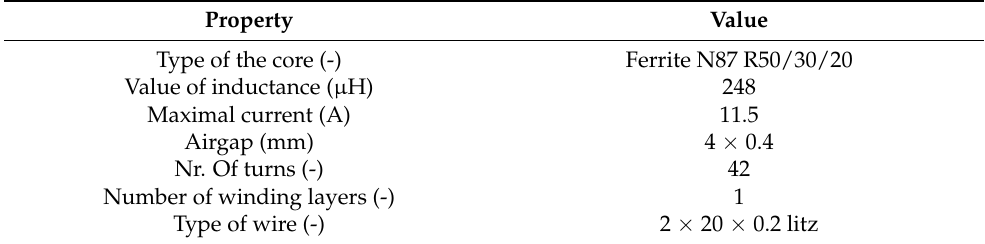
Table 3. Design parameters of the PFC inductors for high-frequency operation.